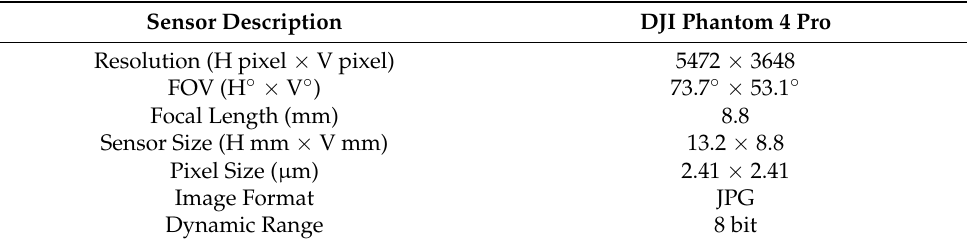
Table 1. UAV imaging sensor details